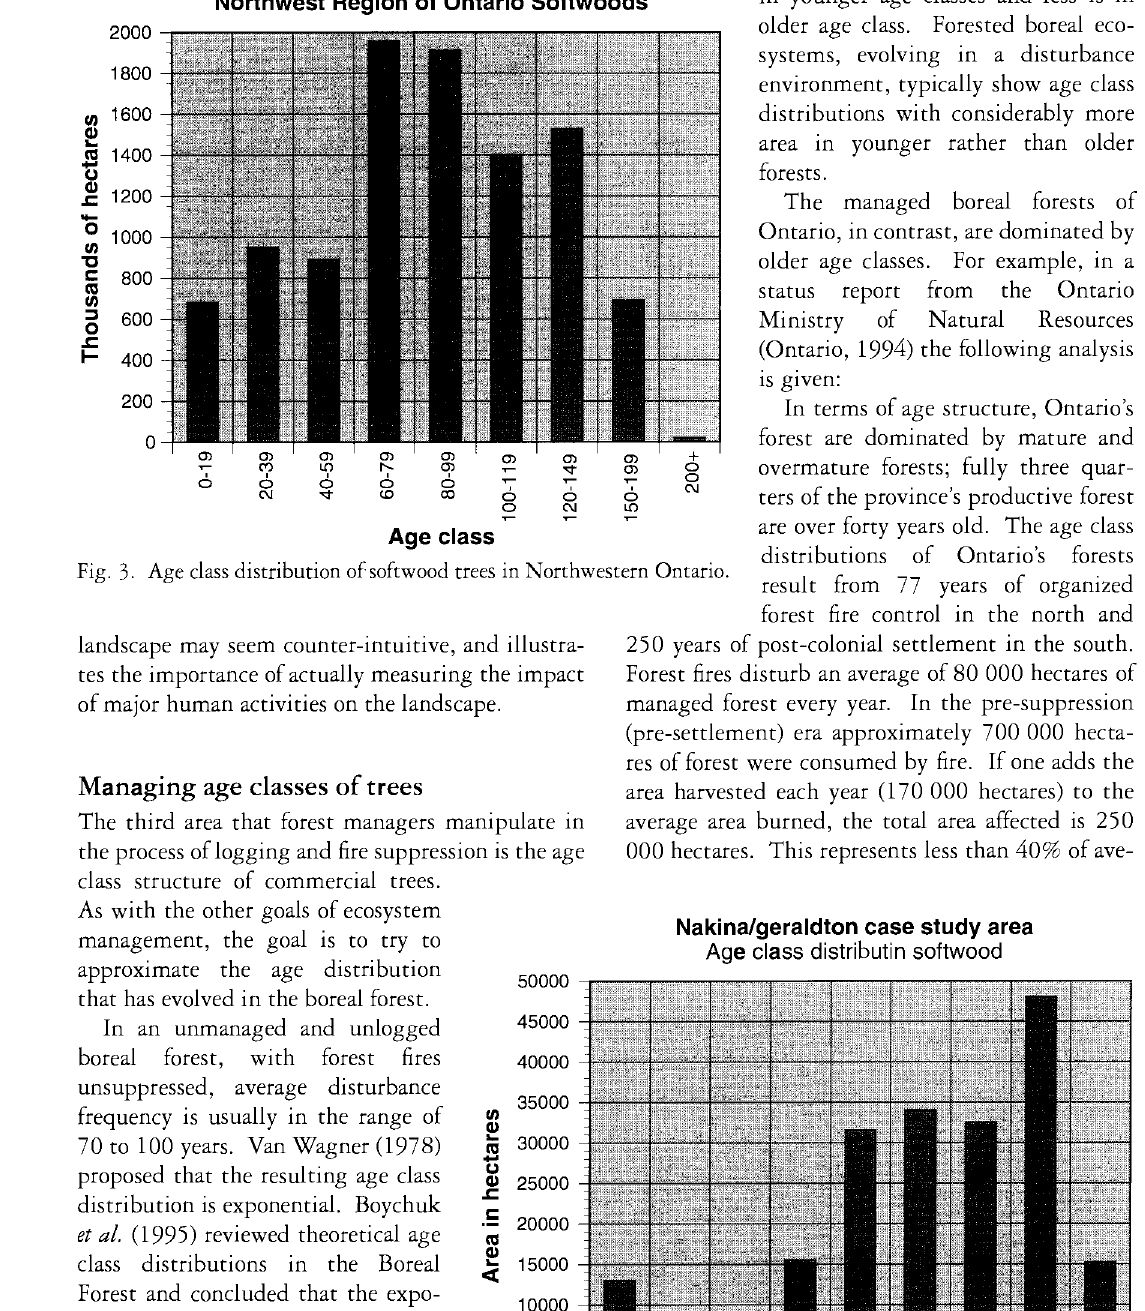
Age class distribution of commercial tree species from the Nakina management unit in Northwestern